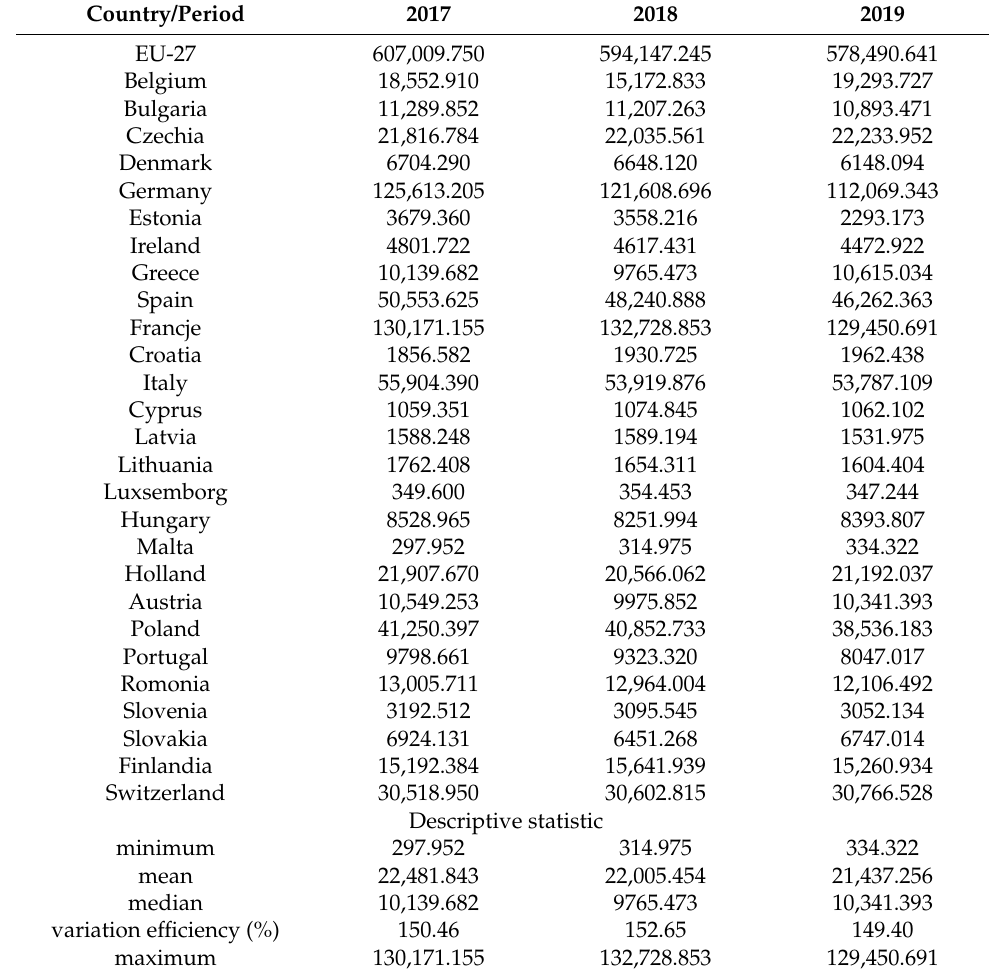
Table 1. Electricity and heat generation in the EU countries (thousand tonnes of oil